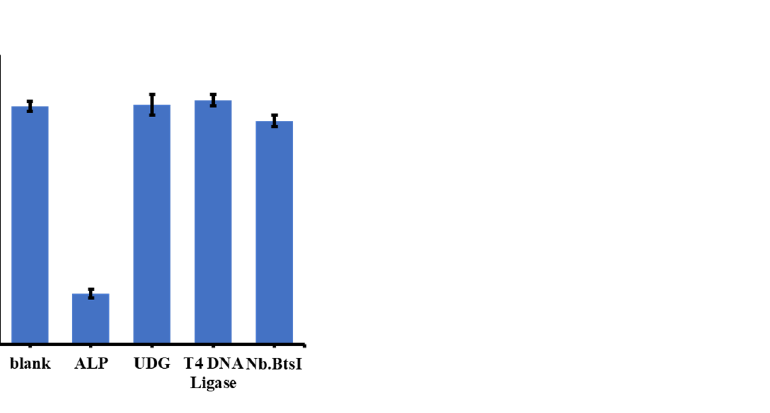
Figure 4. Selectivity assay. The concentrations of ALP, UDG, T4 DNA Ligase, and Nb. BtsI were 5